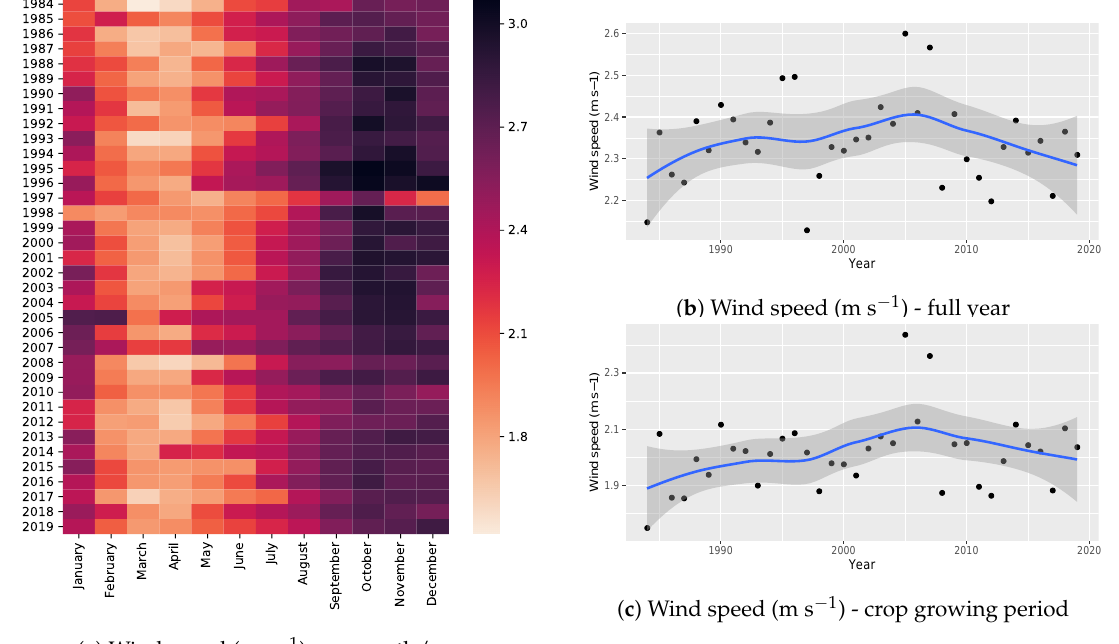
Figure A3. Time series of average wind speed (m s − 1 ) in Guayas from 1984 to 2019. ( a ) Heat-map of wind speed (m s − 1 ) per each month and year. The color scale represents the wind speed in m s − 1 . ( b ) Wind speed averaged during the full year. ( c ) Wind speed averaged during the maize crop growing period in Ecuador (January–May). Each dot represents one record, the blue line shows the smoothed time series and the shaded area represents the 95% confidence